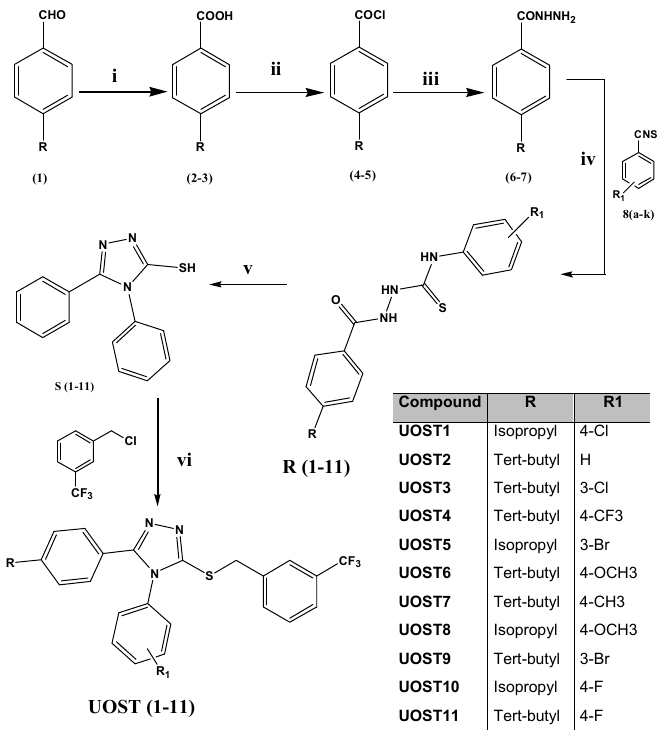
Figure 1. Rational design and synthesis of UoST compounds.